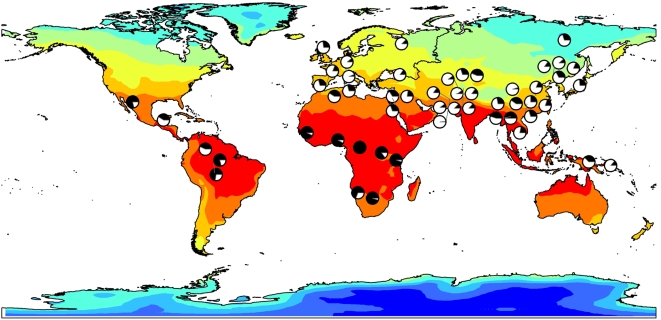
Ancestral allele frequencies for rs9493857 (in black) in the 52 HGDP populations mapped onto a GIS map of Winter Maximum Temperature (matched by hemisphere).Winter Maximum Temperature is the environmental variable with the largest contribution to Winter Principal Component 1.